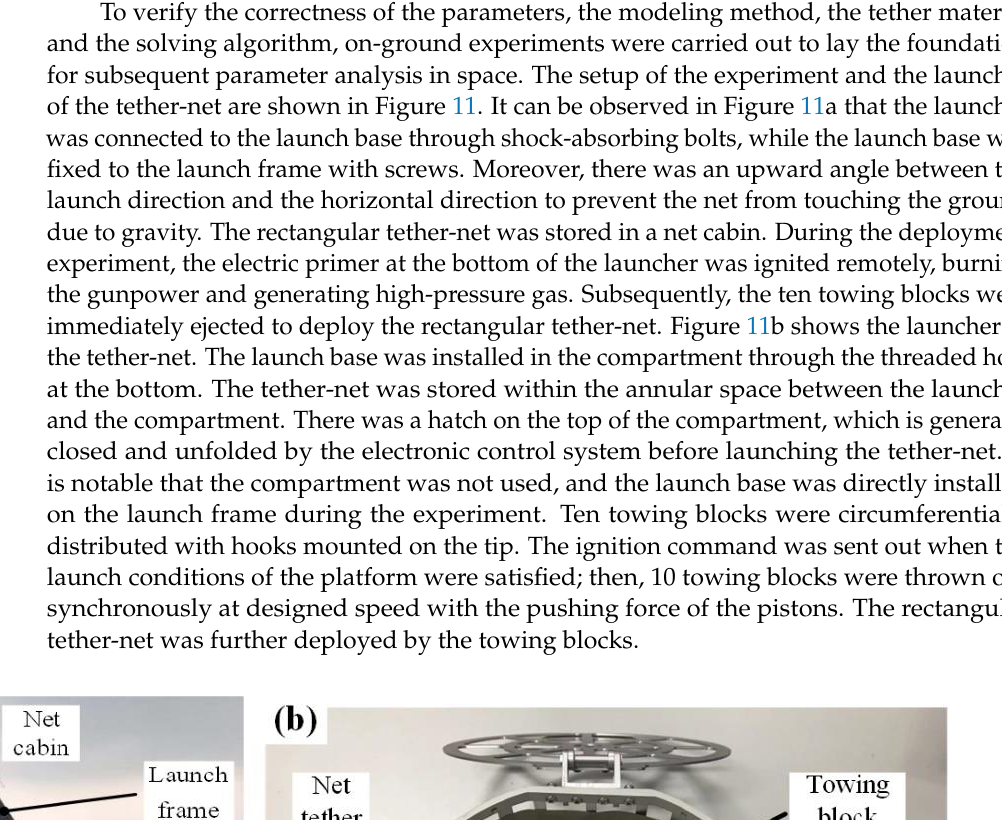
t = 0.55 s Figure 12. Comparison of tether-net configuration between simulations and experiments. ( a ) On- site photos of on-ground experiments. ( b ) Main view of simulation results. ( c ) Top view of simula- tion results.